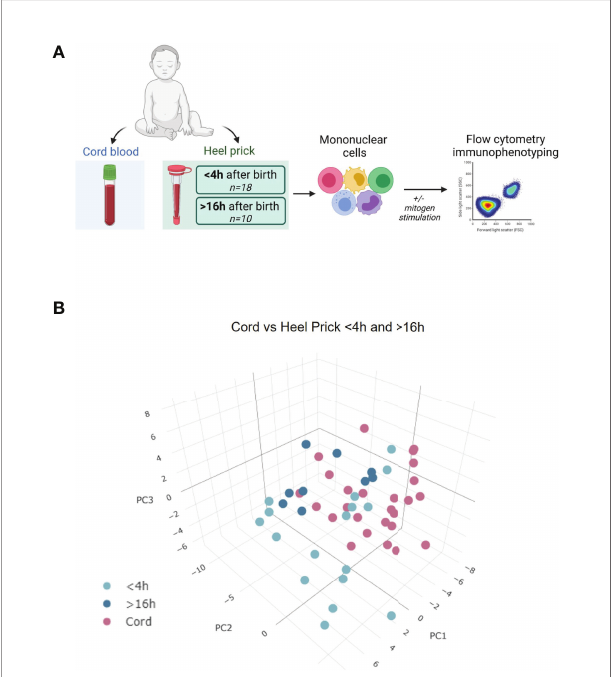
FIGURE 1 | Rapid immune cell changes observed immediately post birth. (A) Experimental design: cord blood and heel prick mononuclear cells were collected at birth (cord blood) or within 48 h post birth (heel prick samples). Cells were phenotyped either immediately post thawing or after 4 h polyclonal stimulation, and cytokine responses and activation markers were measured using multiparametric fl ow cytometry. Created with BioRender.com. (B) 3D PCA visualisation showing the distribution of cord blood samples (pink; n=26) vs paired heel prick samples collected within < 4 h of birth (light blue; n=17) or > 16 h of birth (dark blue; n=9) based on 112 parameters determined by fl ow cytometry (only samples with complete data set